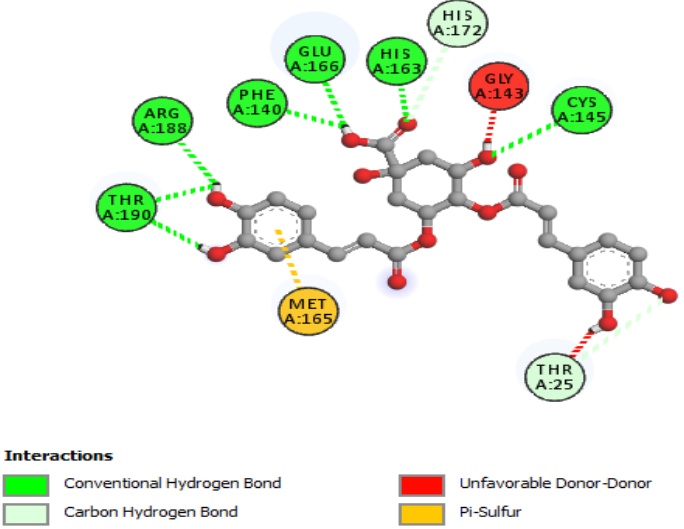
Molecules 2022 , 27 , x FOR PEER REVIEW Figure 2. 2D interactions of 4,5-di- O -caffeoylquinic acid with Mpro. Figure 2. 2D interactions of 4,5-di- O -caffeoylquinic acid with Mpro.